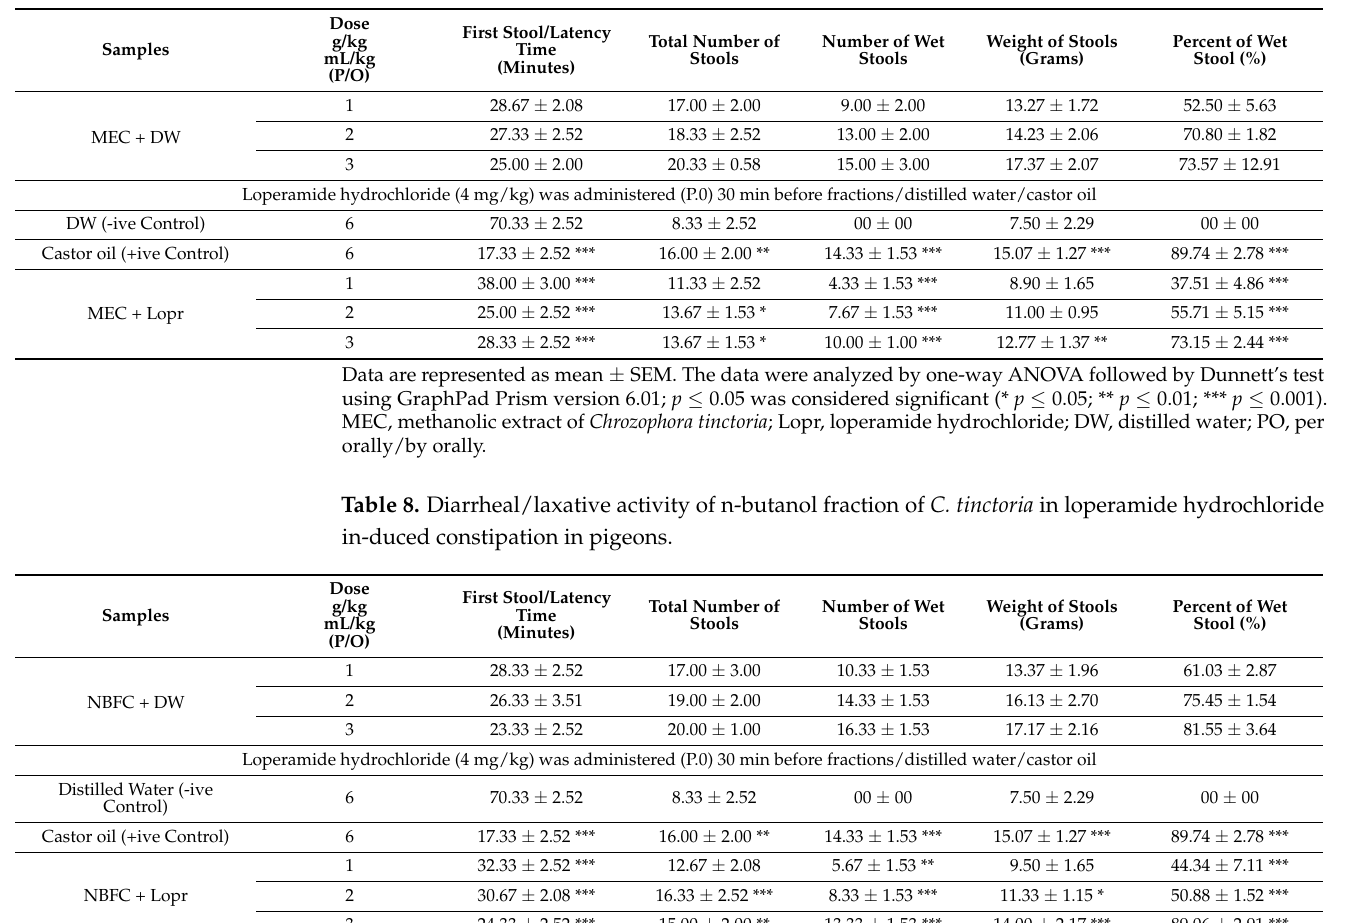
Table 7. Diarrheal/laxative activity of methanolic extract of C. tinctoria in loperamide hydrochloride in-duced constipation in pigeons.